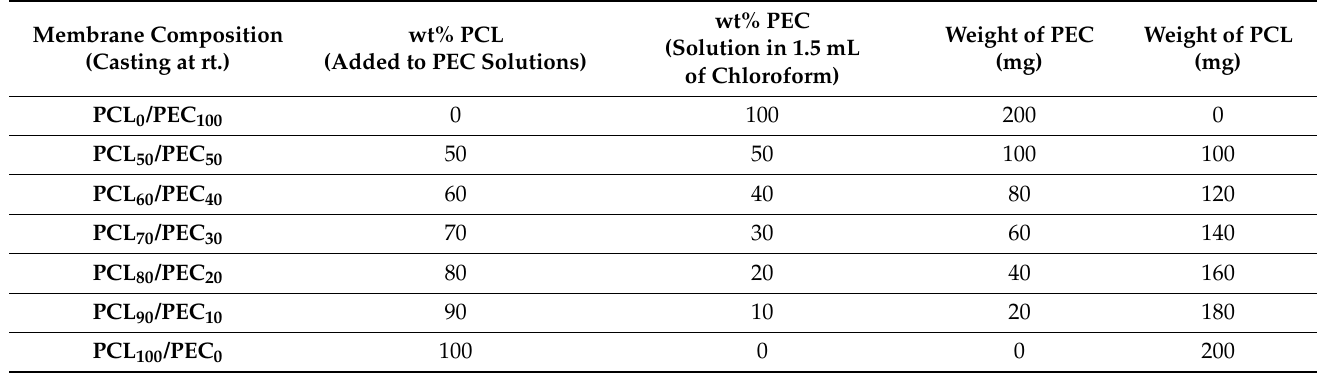
Table 1. Summary of membrane compositions used in this work, along with optimized solution conditions in order to achieve a homogeneous mixture that will subsequently lead all membranes by casting